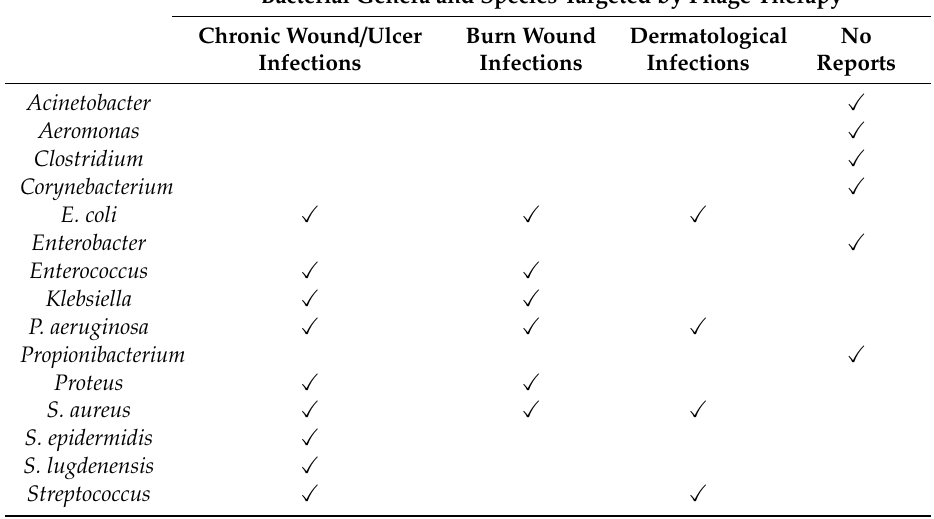
Table 1. Bacterial genera and species for which reports of phage therapy were identified by the systematic search